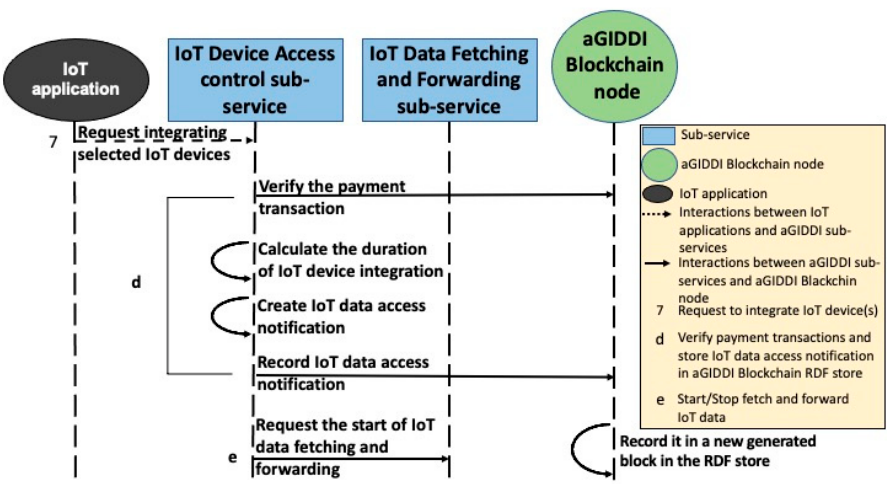
Figure 10. aGIDDI protocol for IoT device integration (controlling the access of IoT devices).